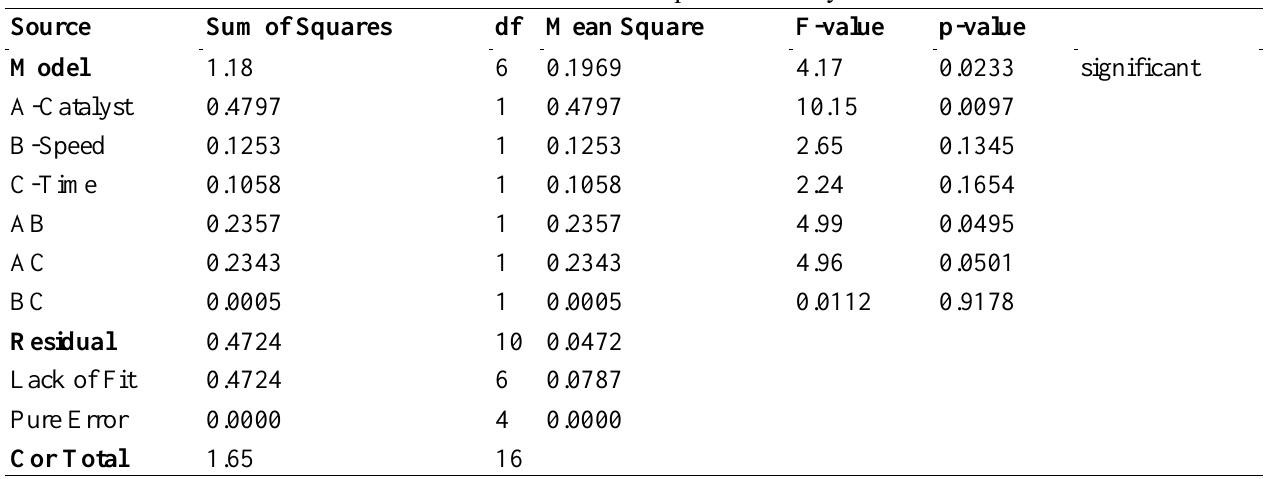
Table 4: ANOVA Table for the “Specific Gravity” 2FI